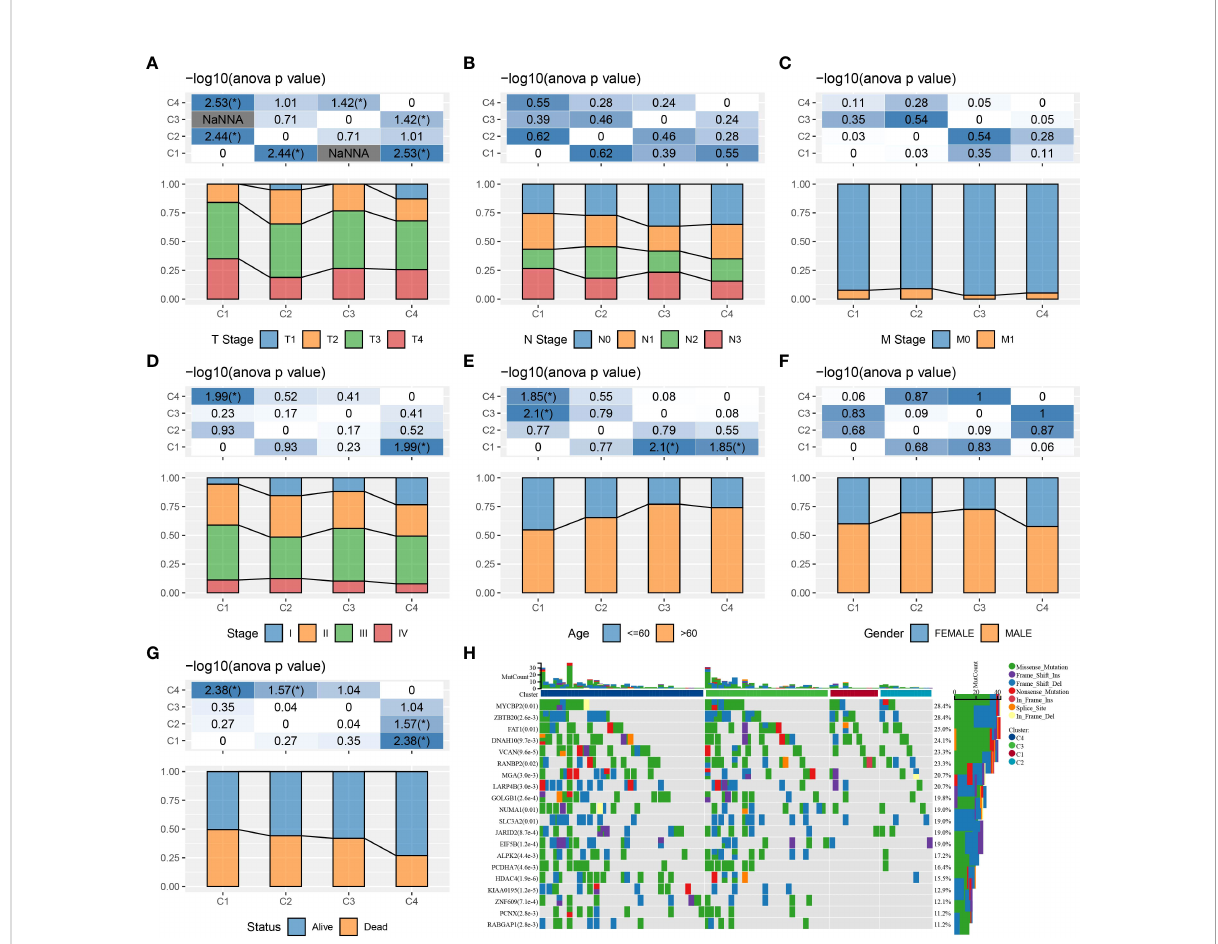
FIGURE 3 The clinicopathological and mutation characteristics of molecular subtypes in the TCGA cohort. (A – G) Comparison of T stage, N stage, M stage, clinical stage, age, gender, and outcome status among different molecular subtypes. (H) Waterfall plots of frequently mutated genes in four molecular subtypes. * P <